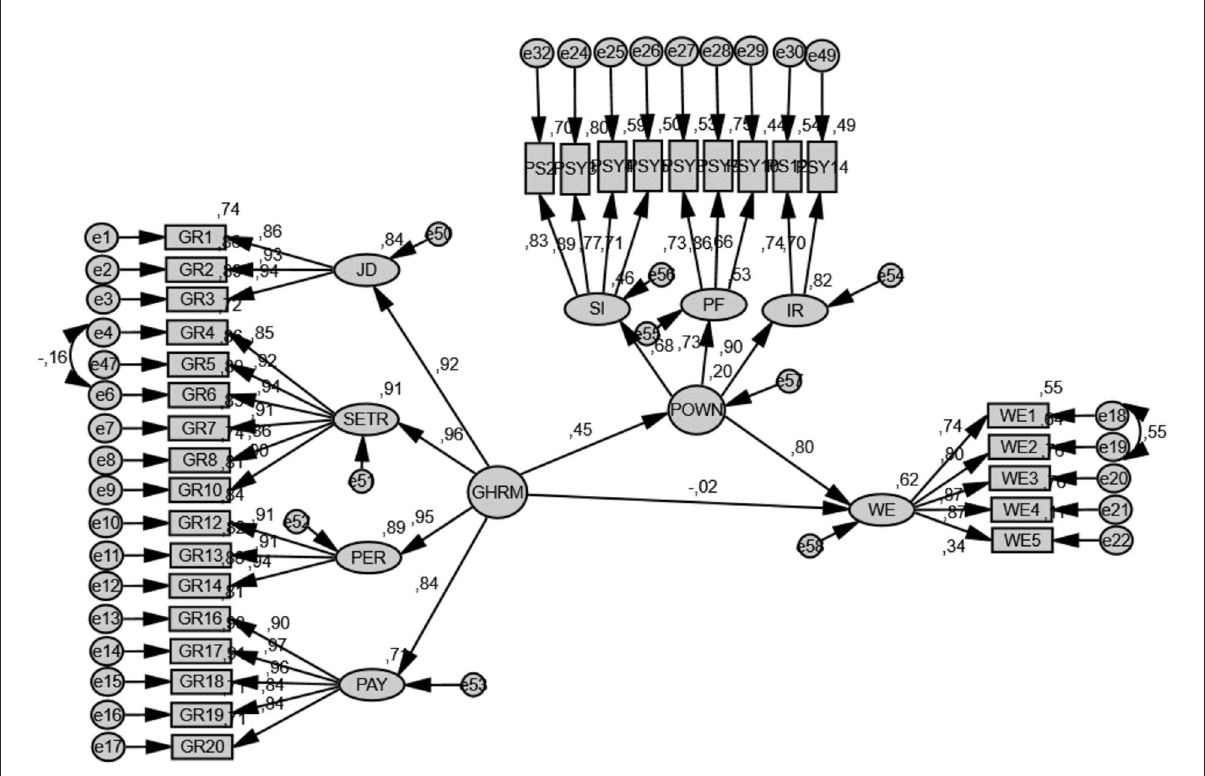
FIGURE4 The structural model with a mediator